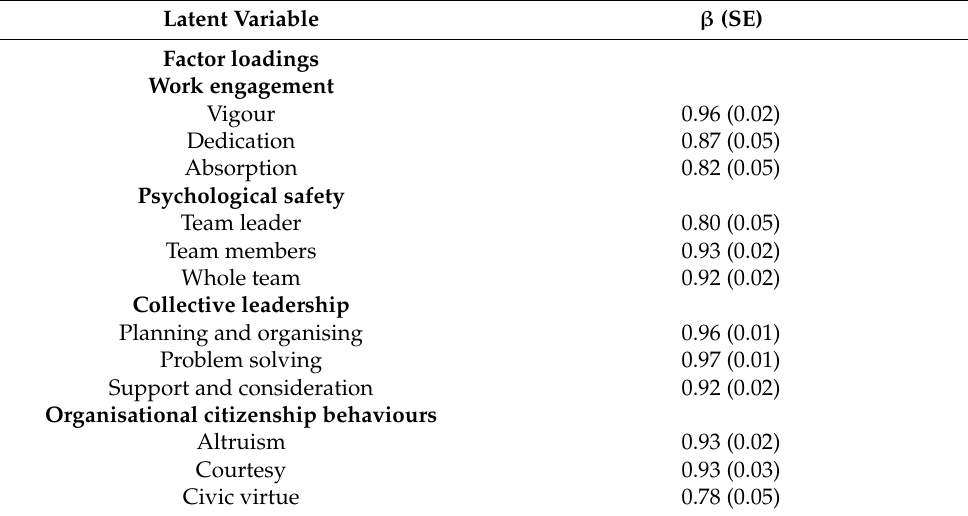
Table A2. Standardised factor loadings of all latent variables.